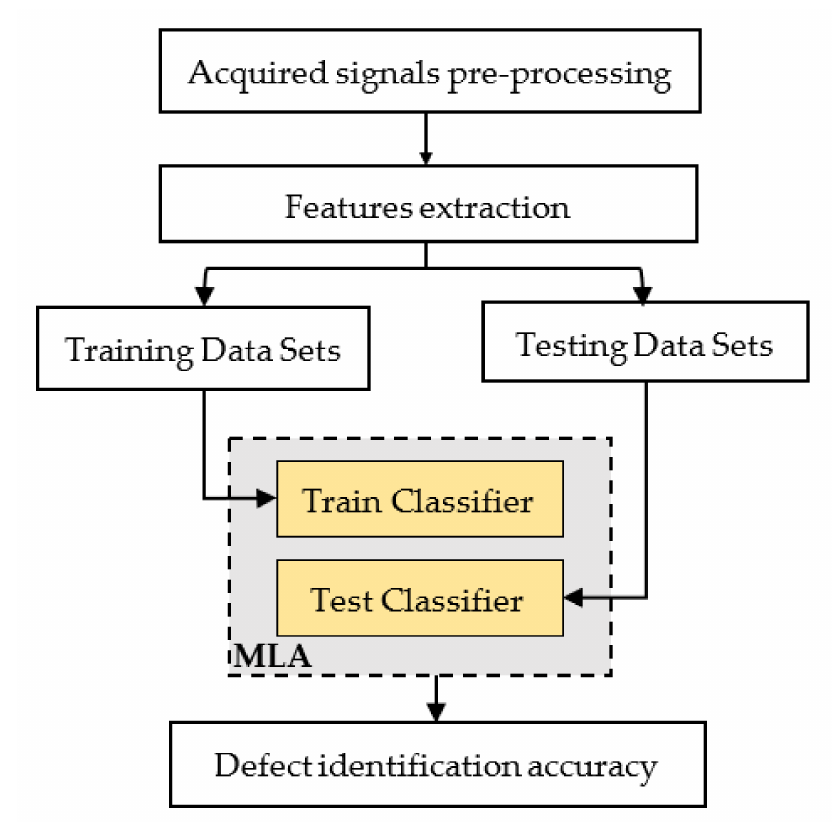
Figure 2. Methodology of bearing defects